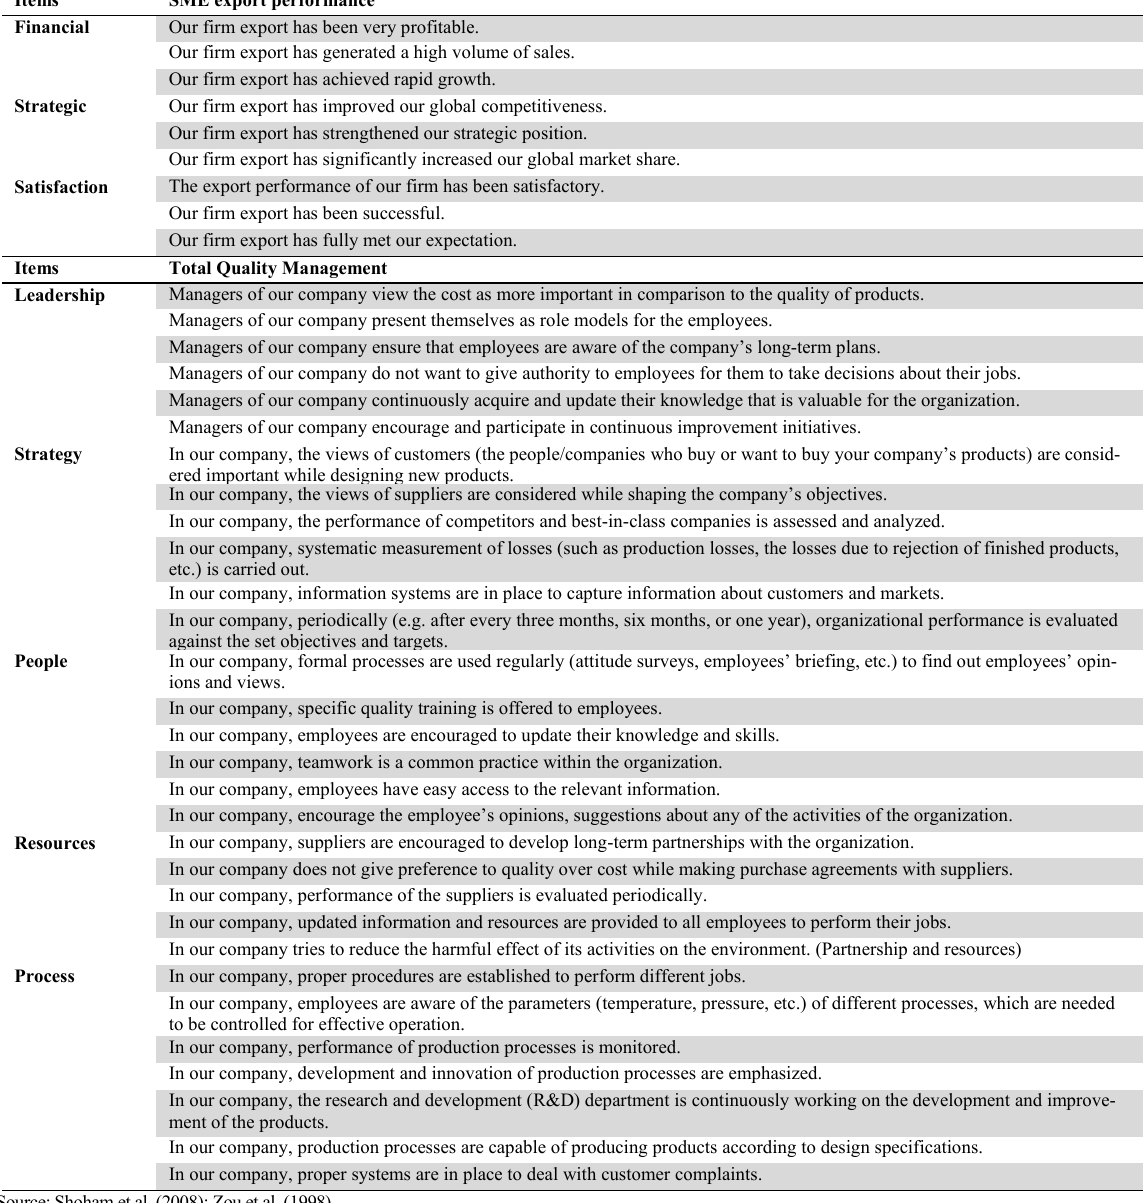
Scale of SME export performance and total quality